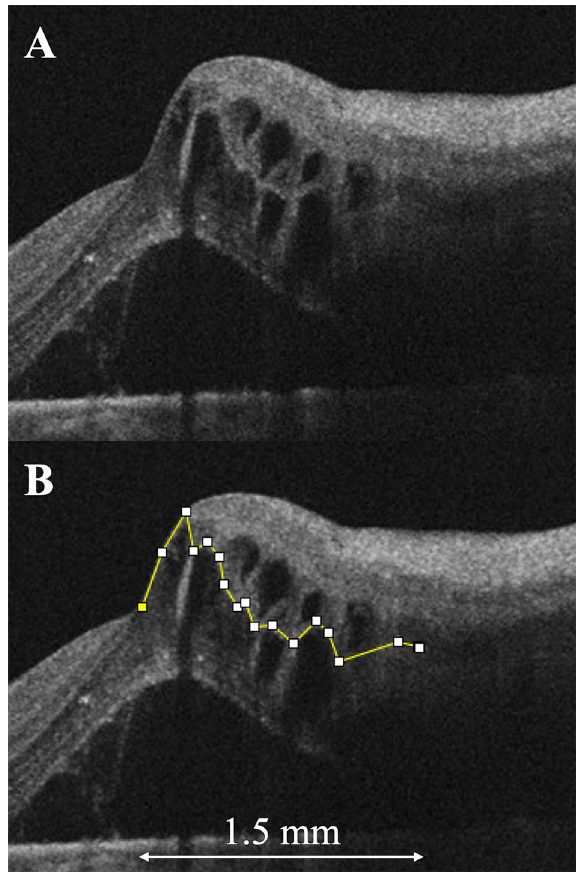
Figure 4. An optical coherence tomography (OCT) image of an eye with branch retinal vein occlusion of a 64-year-old woman who required six anti-vascular endothelial growth factor injections over 1-year follow-up period. ( A ) An OCT image that ran vertically through the fovea at the initial visit shows macular edema, with relatively large cystoid spaces in the inner nuclear layer (INL), large cystoid spaces in the outer plexiform layer (OPL), and subretinal detachment. ( B ) The border between the INL and OPL is not smooth (segmented line). In this case, the jagged ratio is 1.21. Figure is created using ImageJ software version 1.53a (National Institutes of Health, Bethesda, Maryland, USA, available at https:// imagej. nih. gov/